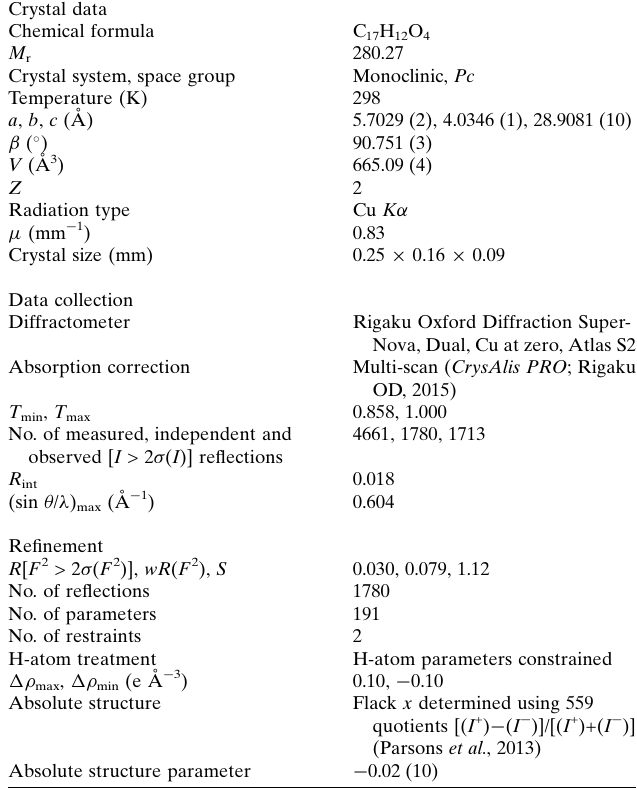
Figure 4 Decomposed two-dimensional fingerprint plots for the title compound. Various close contacts and their relative contributions are indicated.